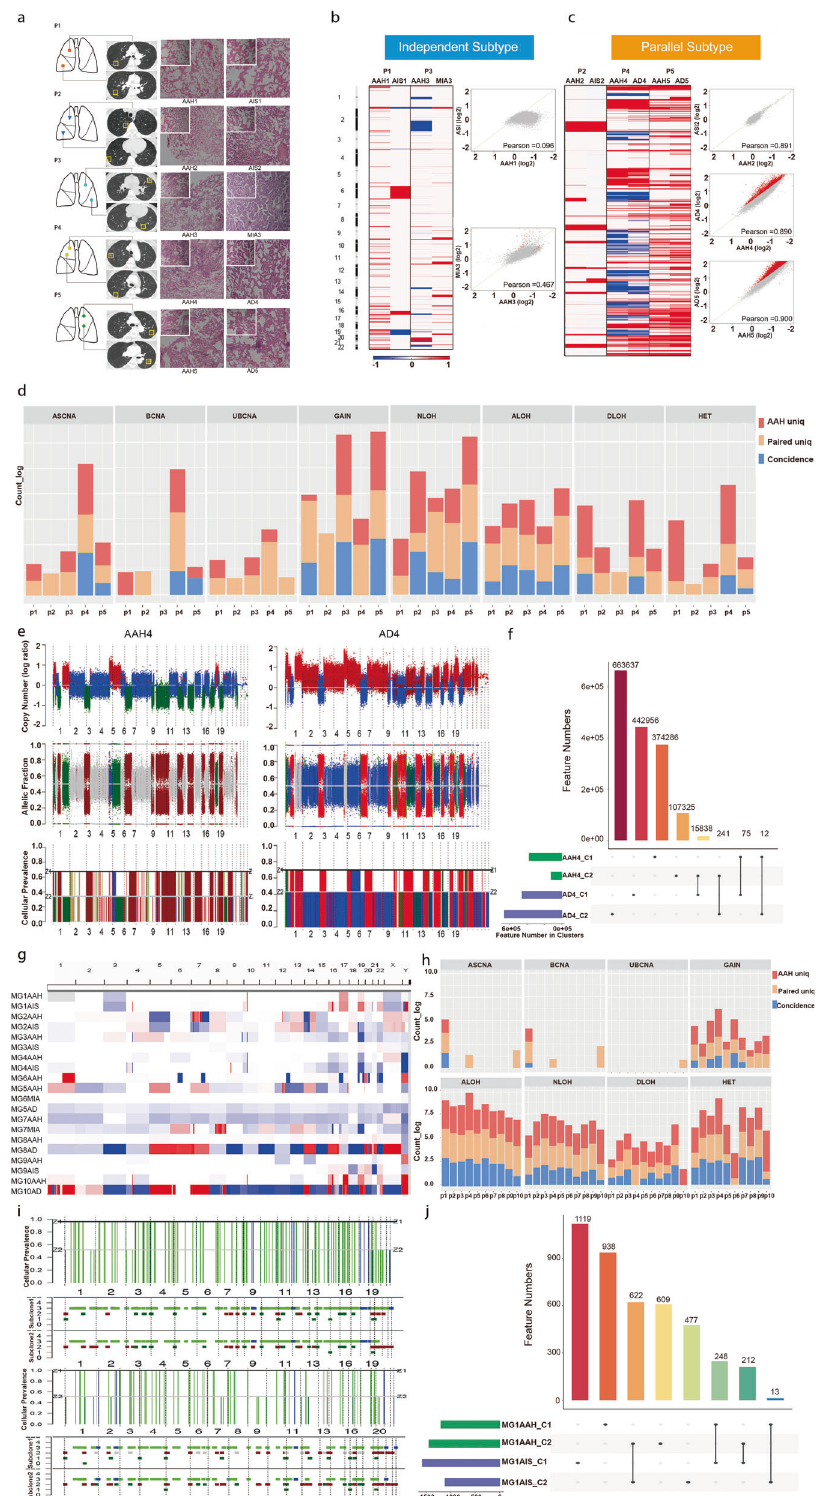
expected to produce low-frequency, low-impact variants that would be unique to each lesion. The model also predicts that SM- GGNs with a parallel lineage relationship will have a high proportion of shared copy number aberrations and structural